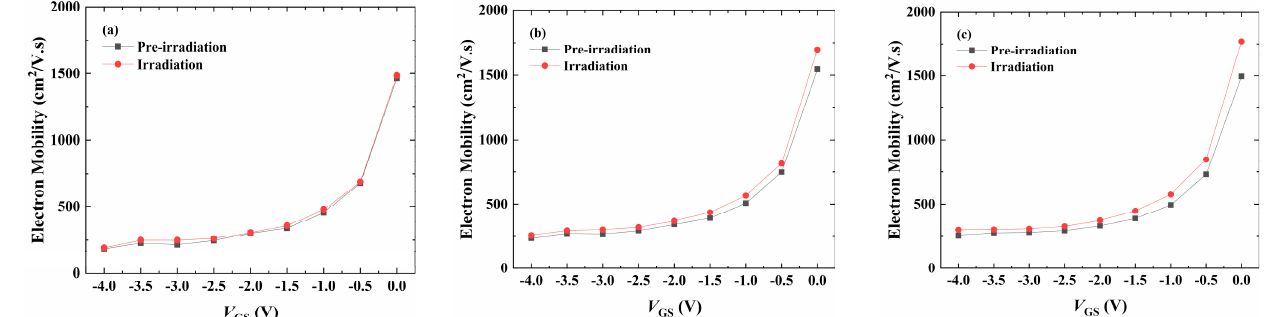
Figure 6. Gate–channel low-field electron mobility µ n of Device 1 before (“Pre-irradiation”) and after (“Irradiation”) proton irradiation as a function of gate voltage with 1 MeV ( a ), 0.6 MeV ( b ), and 0.4 MeV ( c ) proton